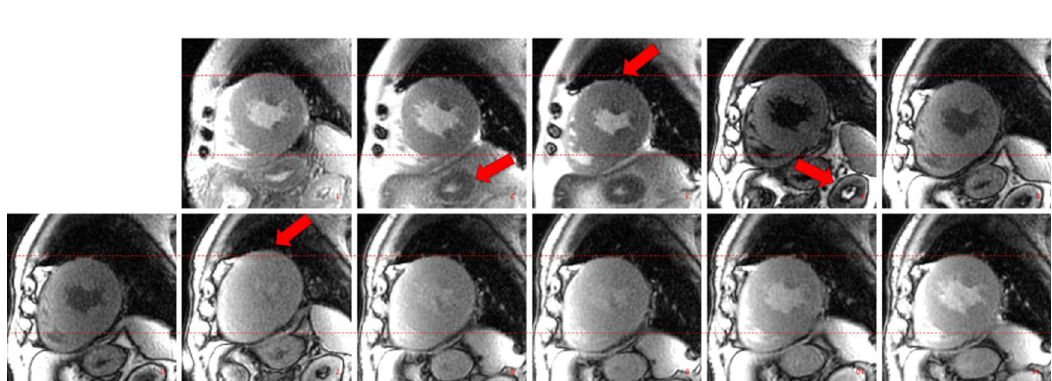
Figure 2. Example cardiac MOLLI series acquired on a 3 T Signa Architect, illustrating the changing tissue contrast. The red arrows indicate anatomical structures affected by motion, compromising T1 mapping accuracy.